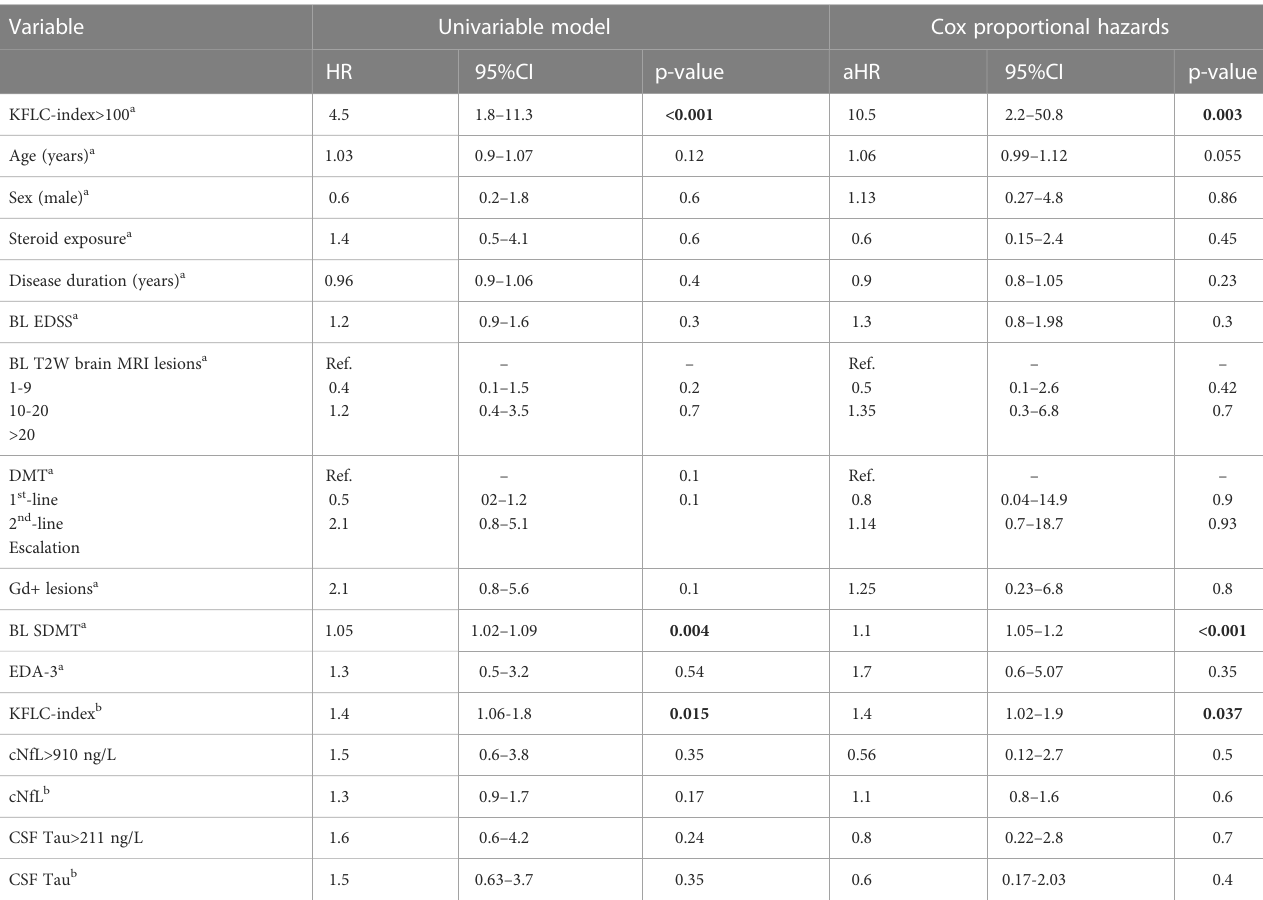
TABLE 2 Univariable and multivariable cox proportional hazards regression models for intrathecal biomarkers measured at diagnosis as well as covariates and prediction of SDMT score reduction in RRMS patients.